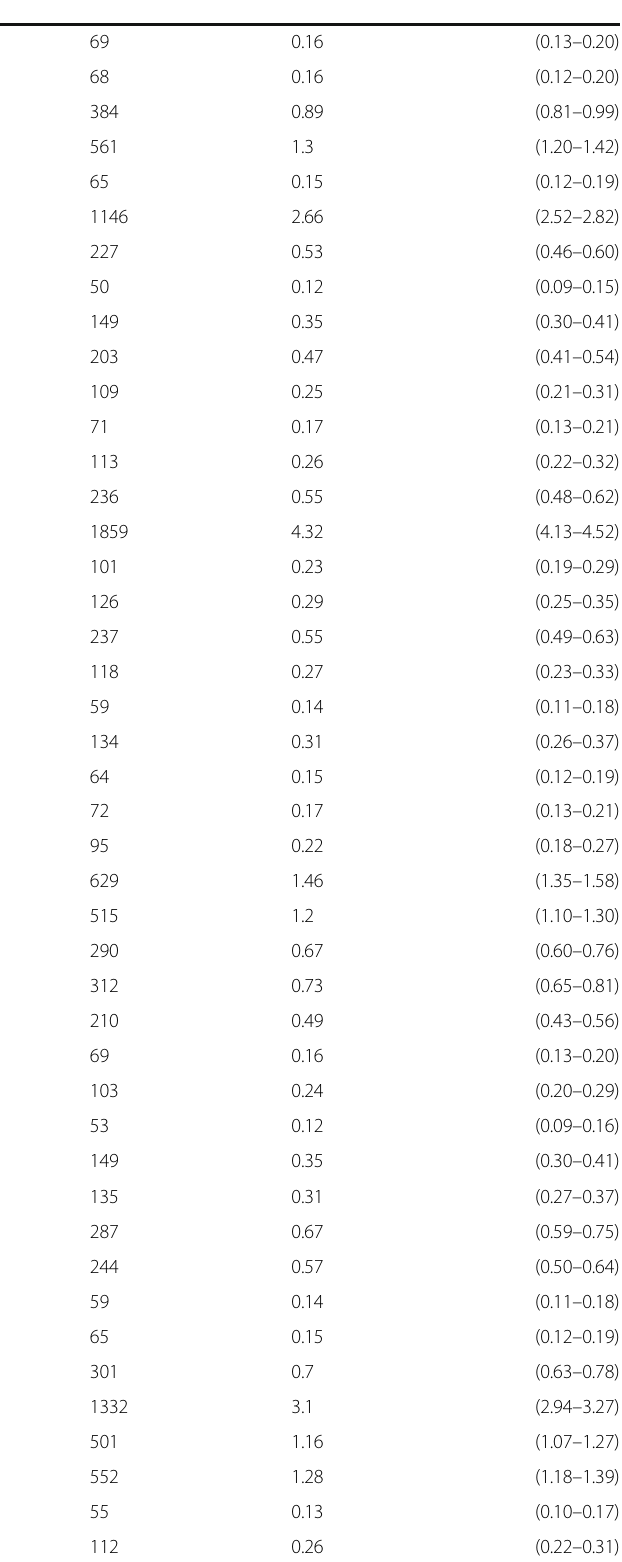
Table 3 List of number of reports and overall prevalence of the most commonly reported conditions/diseases (with ≥ 50 reports in unique live dogs, n = 43,005)